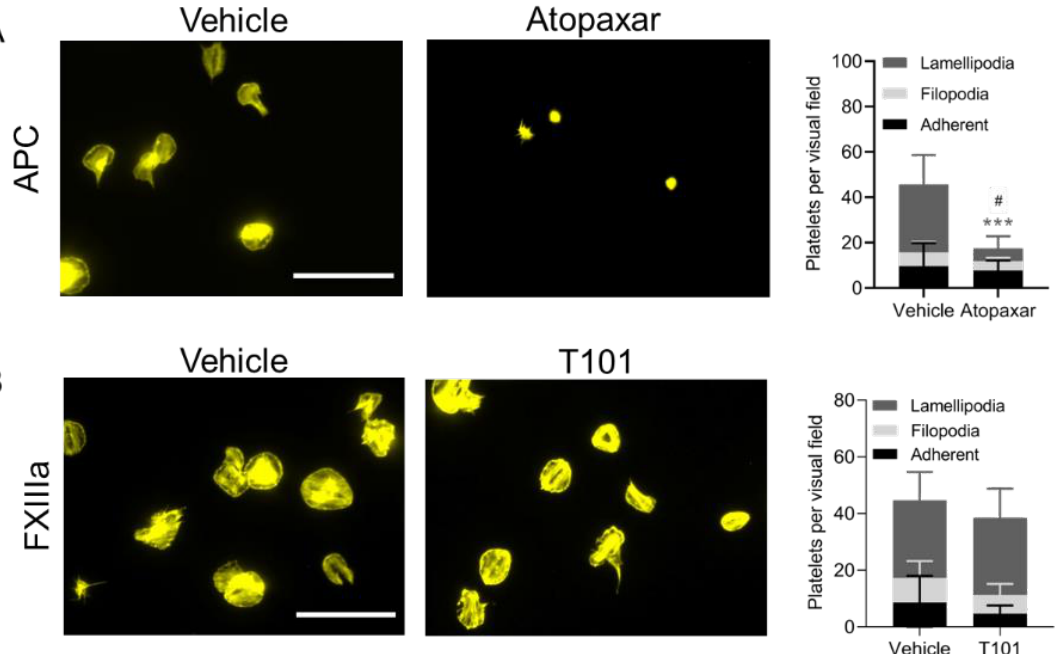
Figure 4. Immobilized APC and FXIIIa induce platelet adhesion and spreading. ( A ) Role of PAR-1 in APC-induced platelet spreading. Washed platelets (20 × 10 9 platelets/L) were incubated with vehicle (DMSO) or Atopaxar (5 µ M) and were allowed to spread for 45 min under static conditions, on a surface coated with APC. The platelets were then fixed, permeabilized and stained with CF543- phalloidin. Spreading was assessed with fluorescence microscopy (bars, 20 µ m). Two-way ANOVA, *** p < 0.001 compared between lamellipodia, mean ± SD, n = 4. Unpaired t -test, # p < 0.05 comparison of platelets per visual field, mean ± SD, n = 4. ( B ) FXIIIa-induced platelet spreading is independent of transglutaminase activity. Washed platelets (20 × 10 9 platelets/L) were treated with vehicle or transglutaminase inhibitor T101 (20 µ M) and were allowed to spread for 45 min under static conditions, on surfaces coated with FXIIIa. Samples were fixed, permeabilized and stained with CF543-phalloidin. Spreading was assessed by fluorescence microscopy (bars, 20 µ m). Two-way ANOVA, not significant, mean ± SD, n = 3–4. Unpaired t -test, not significant, mean ± SD, n =